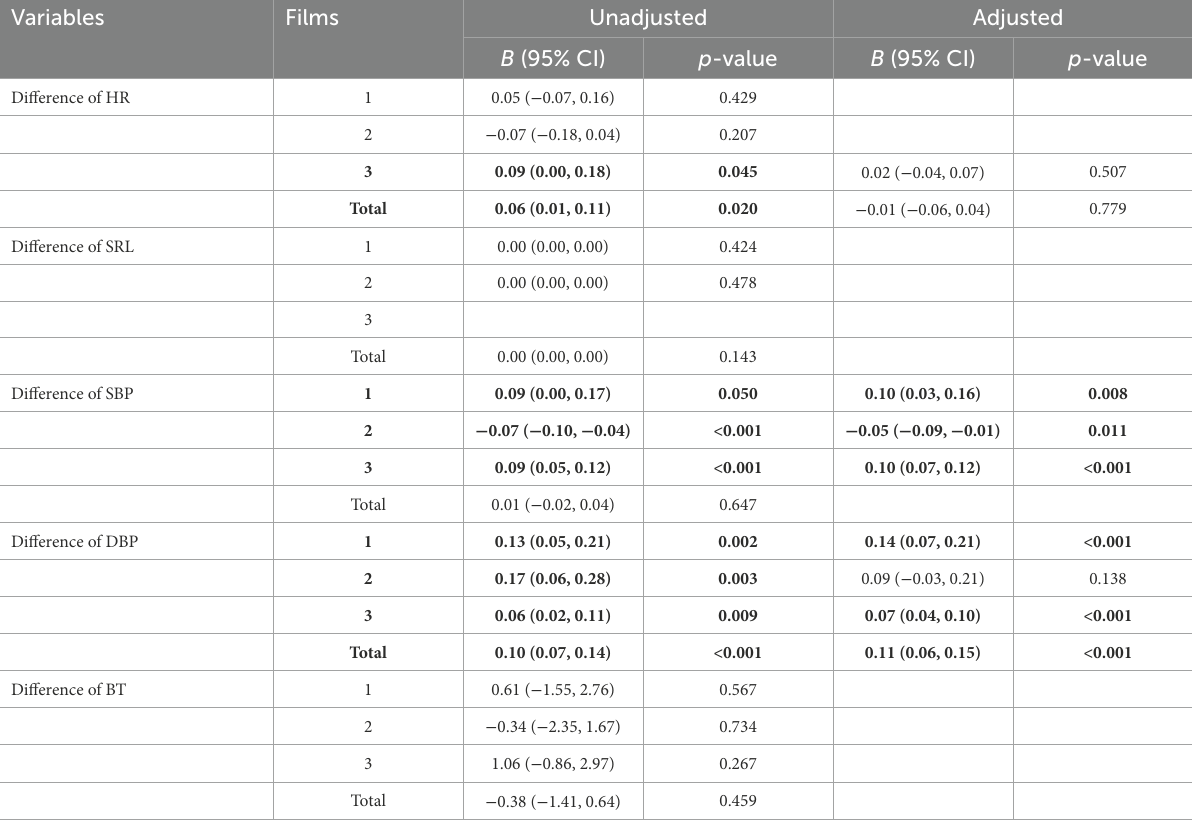
TABLE 3 The unadjusted and adjusted impact of variable differences on the NAQ difference by